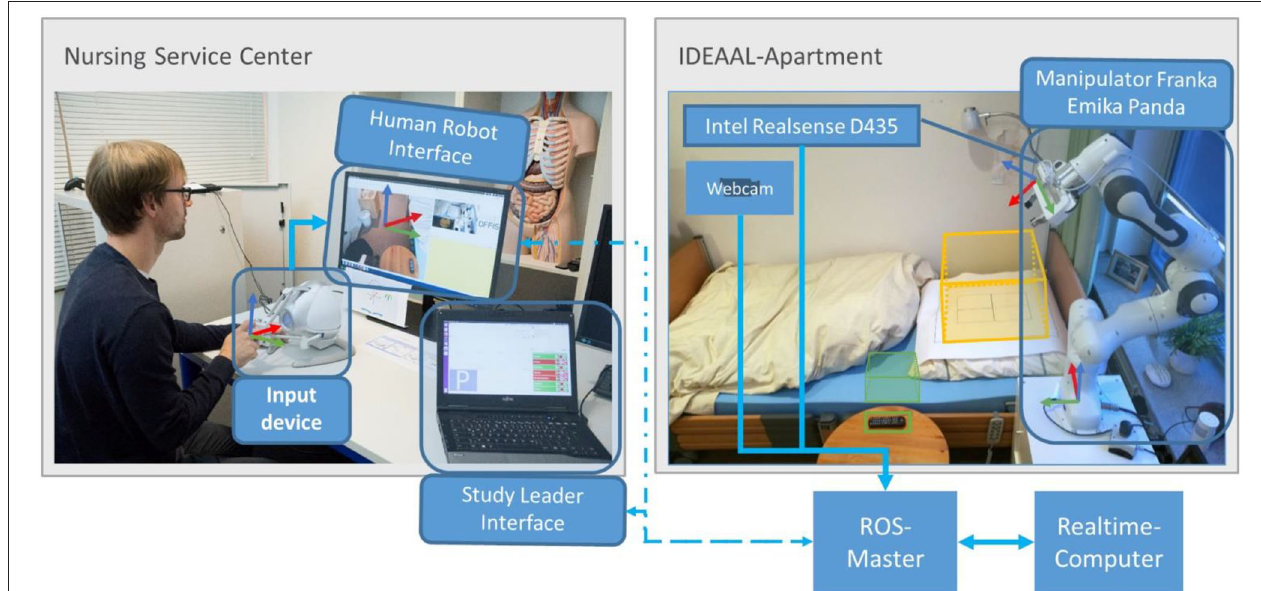
FIGURE 2 | Architecture diagram of the system. It shows the division of the system into rooms and their